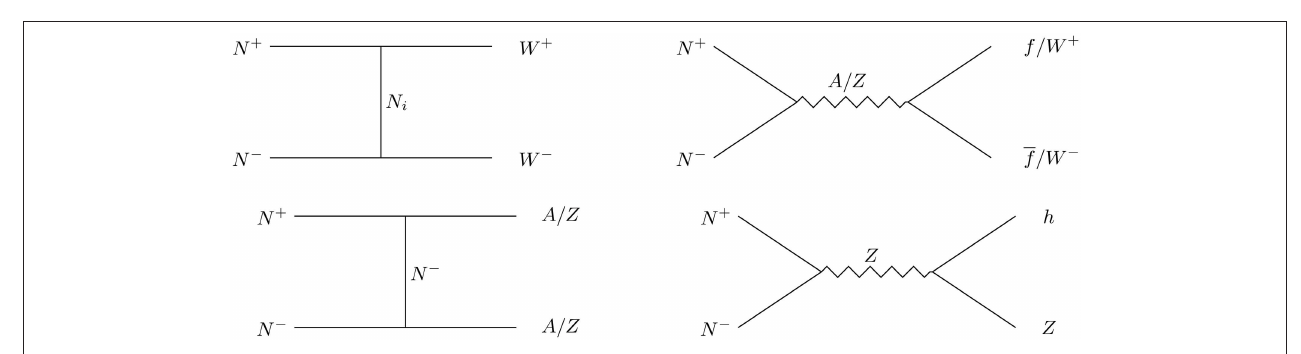
FIGURE 19 | Co-annihilation process of charged fermions N ± to SM particles in final states.